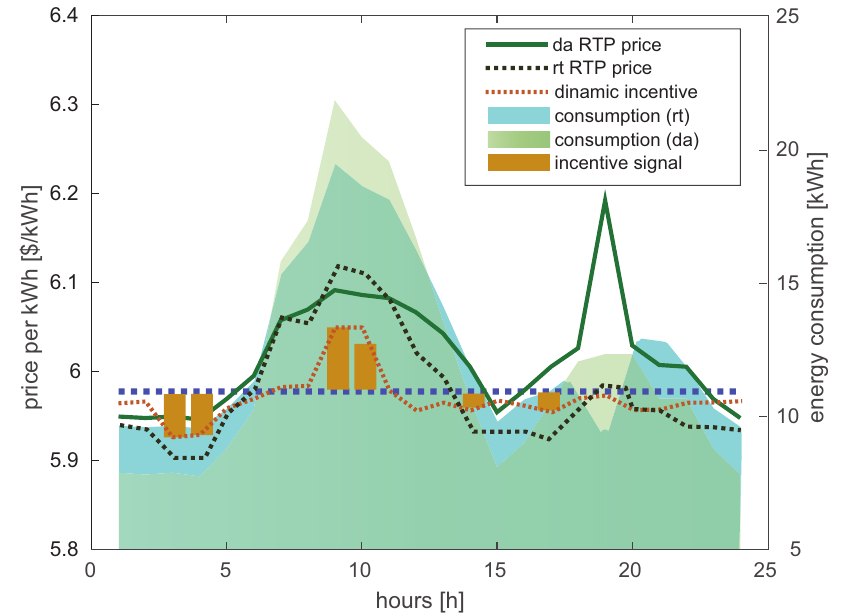
Figure 20. Long–Short term